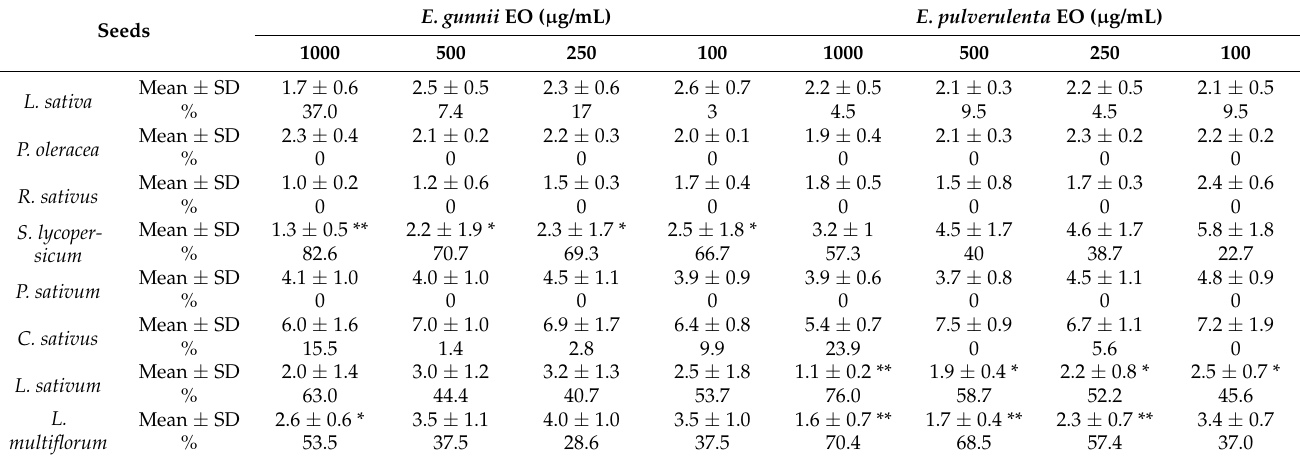
Table 4. Inhibition of radical elongation of L. sativa, P. oleracea, R.sativus, S. lycopersicum, P. sativum, C. sativus, L. sativum , and L. multiflorum seeds treated with different doses. Results are reported as the mean ± SD of three experiments. * p <0.05, ** p <0.01, vs . control (inhibition = 0), according to two way ANOVA followed by Tuckey’s multiple comparison test, at the significance level of p <